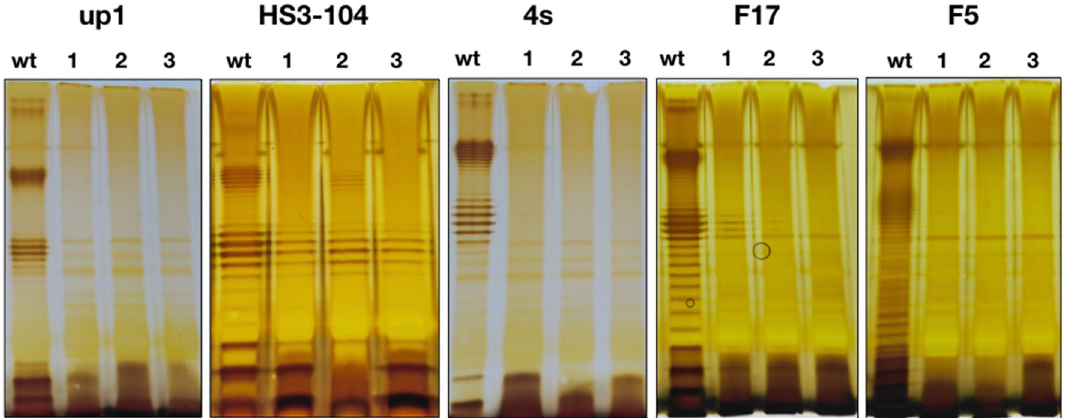
Figure 1. LPS profiles of the E. coli strains used and their derivative the panels—the wild type cells, lanes 1–3—three lysogenic clones for each